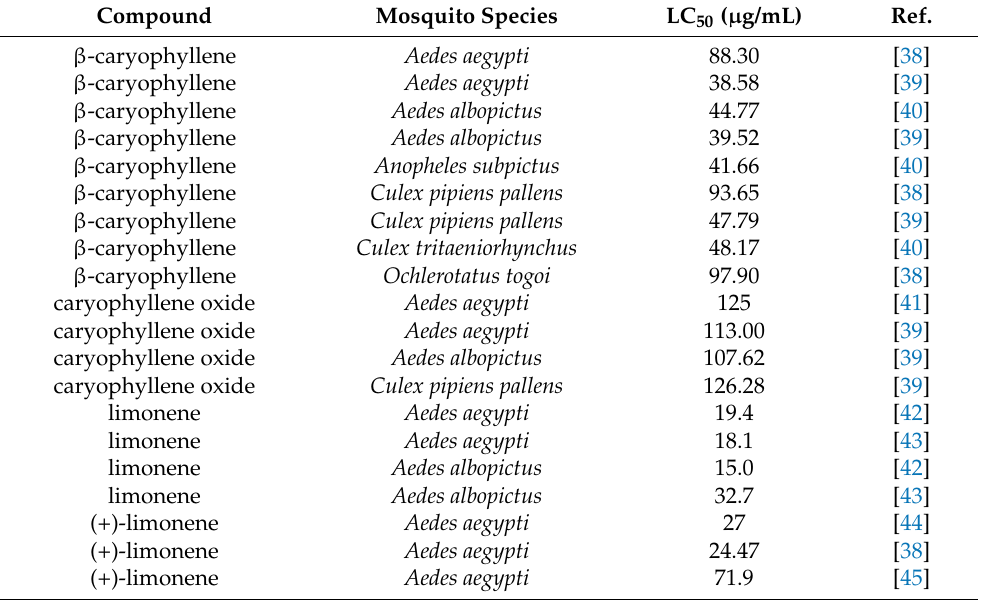
Table 7. Mosquito larvicidal activities (24 h LC 50 ) of essential oil components against various mosquito